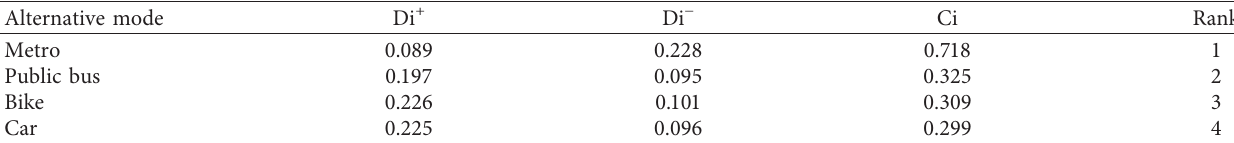
Table 5: TOPSIS results for the respondents.